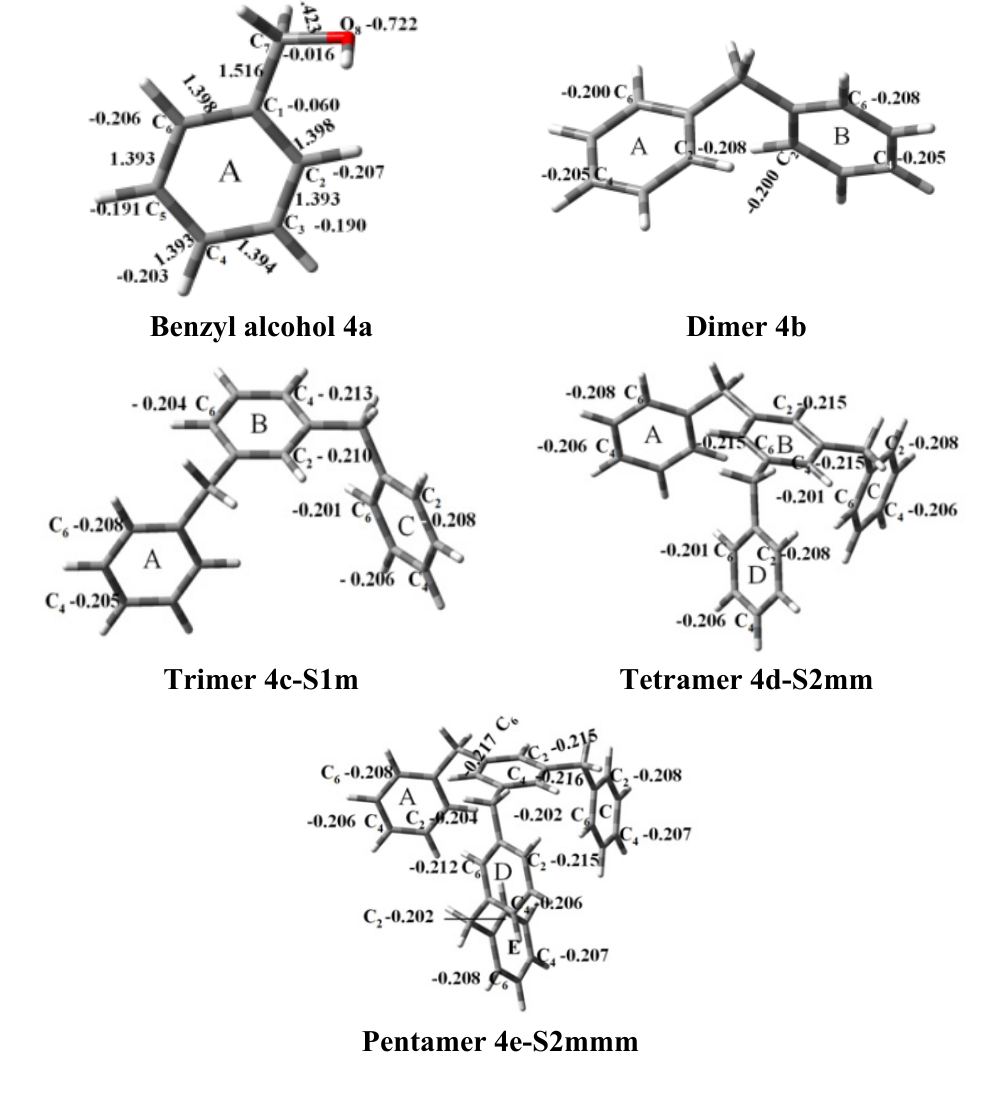
Figure 2. Optimised structures obtained at the B3LYP/6-311G(d,p)